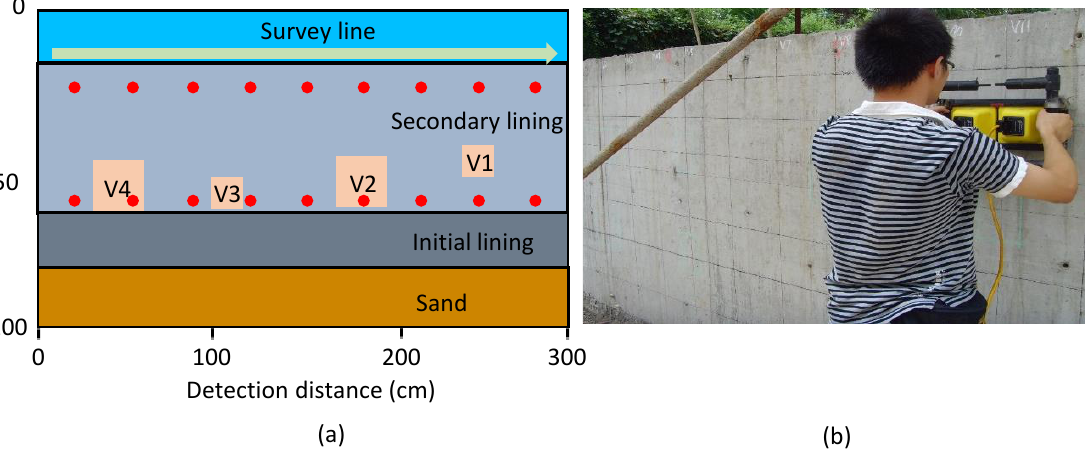
Figure 11. Physical model for real-world GPR data acquisition. ( a ) cross-section of the model, and ( b ) the GPR survey line along the lining